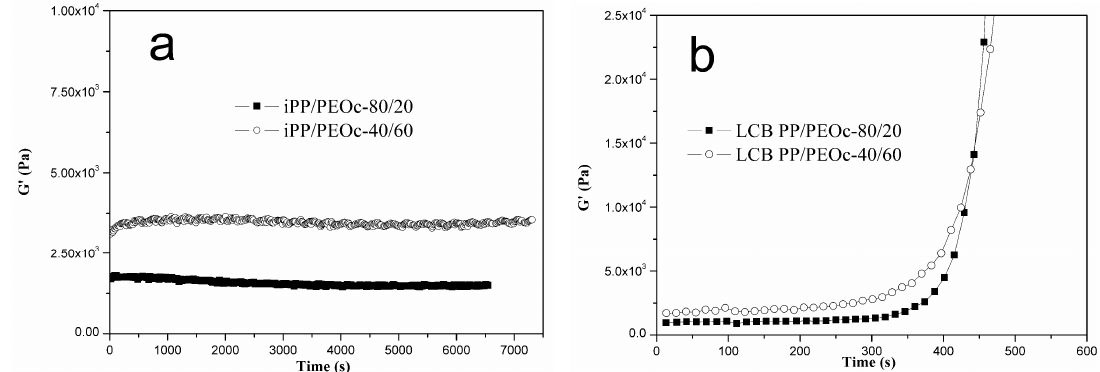
Figure 4. Storage modulus development curves at 146 ◦ C for ( a ) iPP/PEOc-80/20 and iPP/PEOc-40/60; and ( b ) LCB PP/PEOc-80/20 and LCB PP/PEOc-40/60 blends.